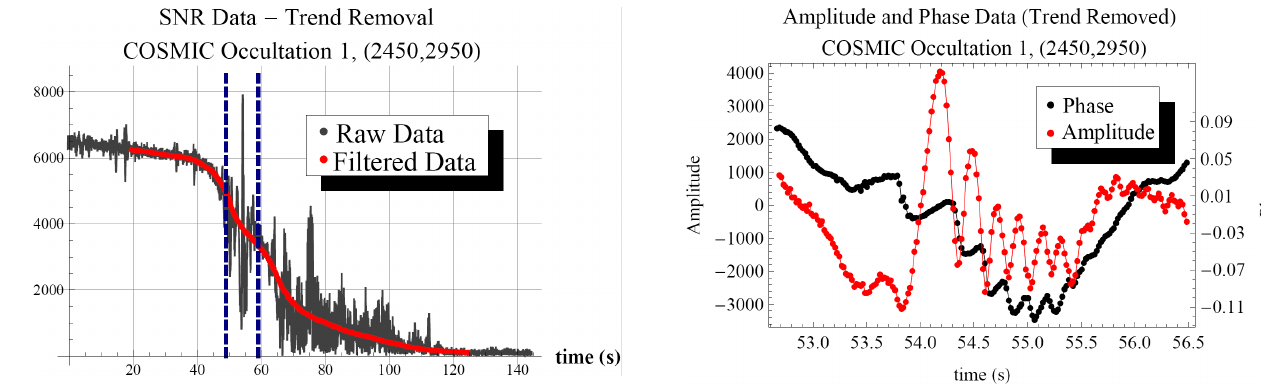
Fig. 28. De-trended amplitude and phase time series (in seconds) from the analysis window for occultation 1. (Between the vertical, dashed blue lines in Fig. 26.) Note spike just after 54s, and oscilla- tions (“ringing”) for the subsequent 1.5s.